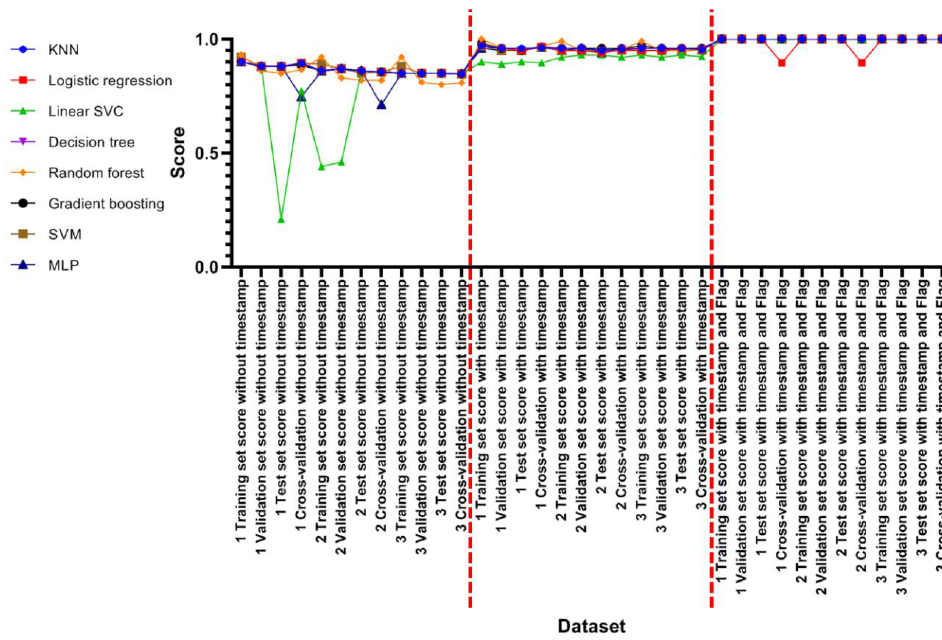
Figure 7. Comparison of performance evaluation according to each set and cross-validation by features.